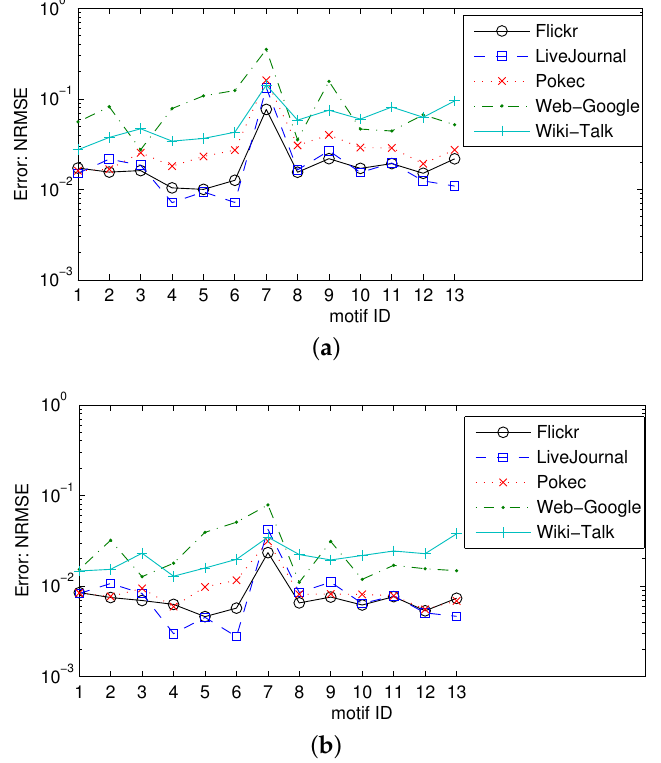
( 3 ) Figure 7. NRMSEs of ˆ n , the estimates of three-node directed motif frequencies for p = 0.01 and i p = 0.05, respectively. Flickr, Pokec, LiveJournal,Wiki-Talk, and Web-Google have 1.35 × 10 10 , 2.02 × 10 9 , 6.90 × 10 9 , 1.2 × 10 10 , and 7.00 × 10 8 three-node CIS, respectively: ( a ) p = 0.01; ( b ) p =